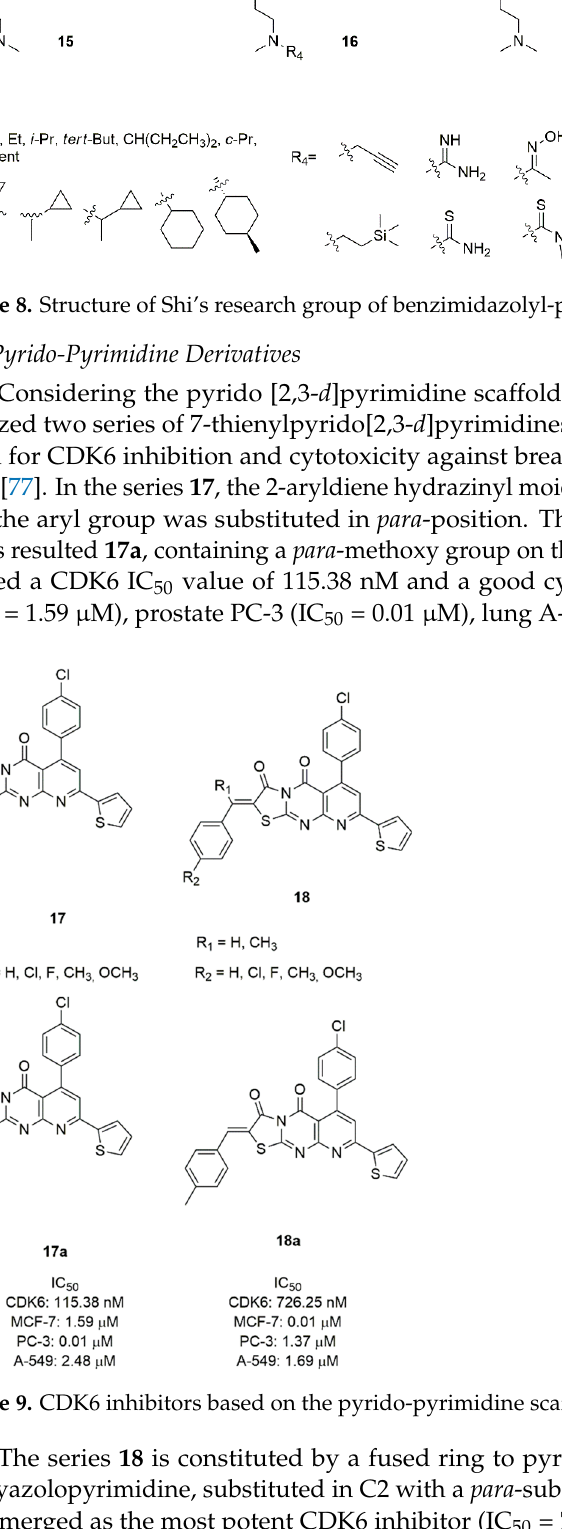
Figure 9. CDK6 inhibitors based on the pyrido-pyrimidine scaffold.